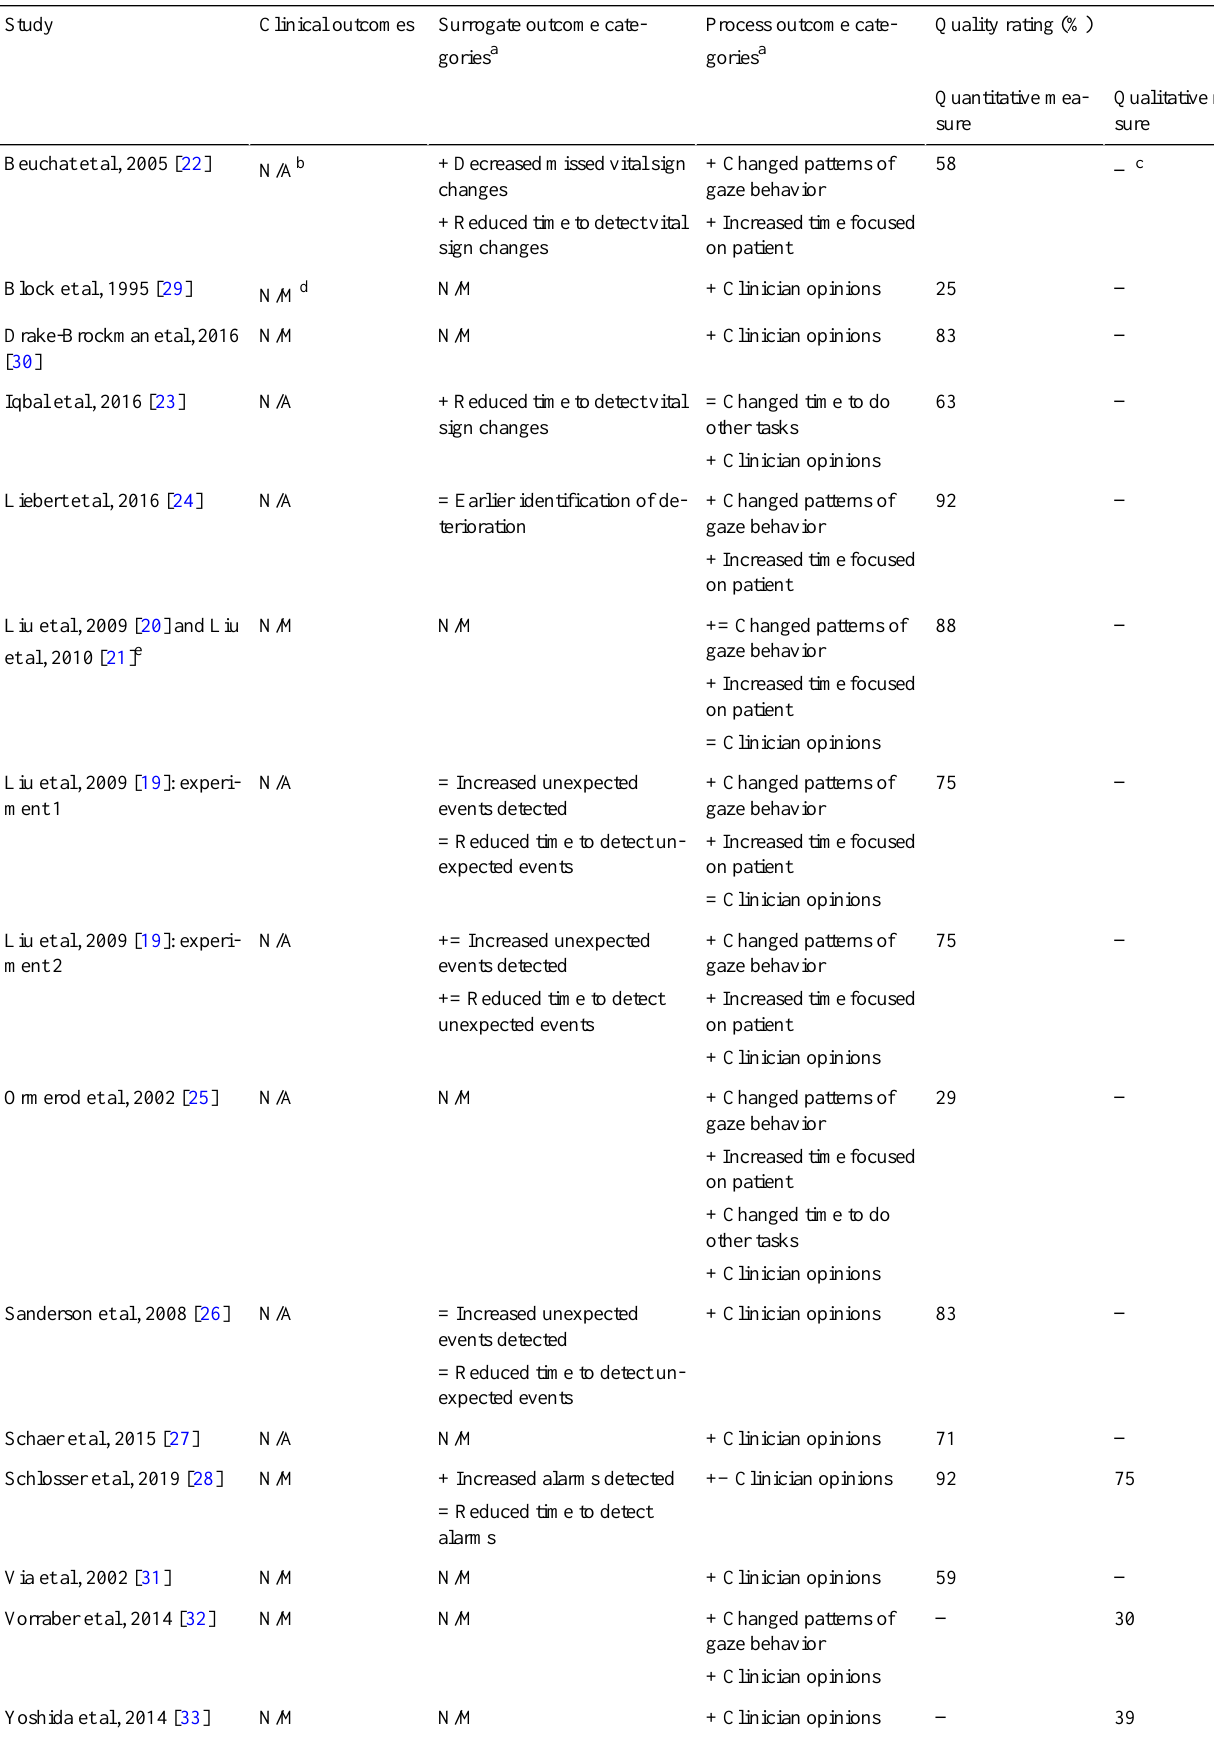
Table 2. Summary of the clinical, surrogate, and process outcomes considered in each